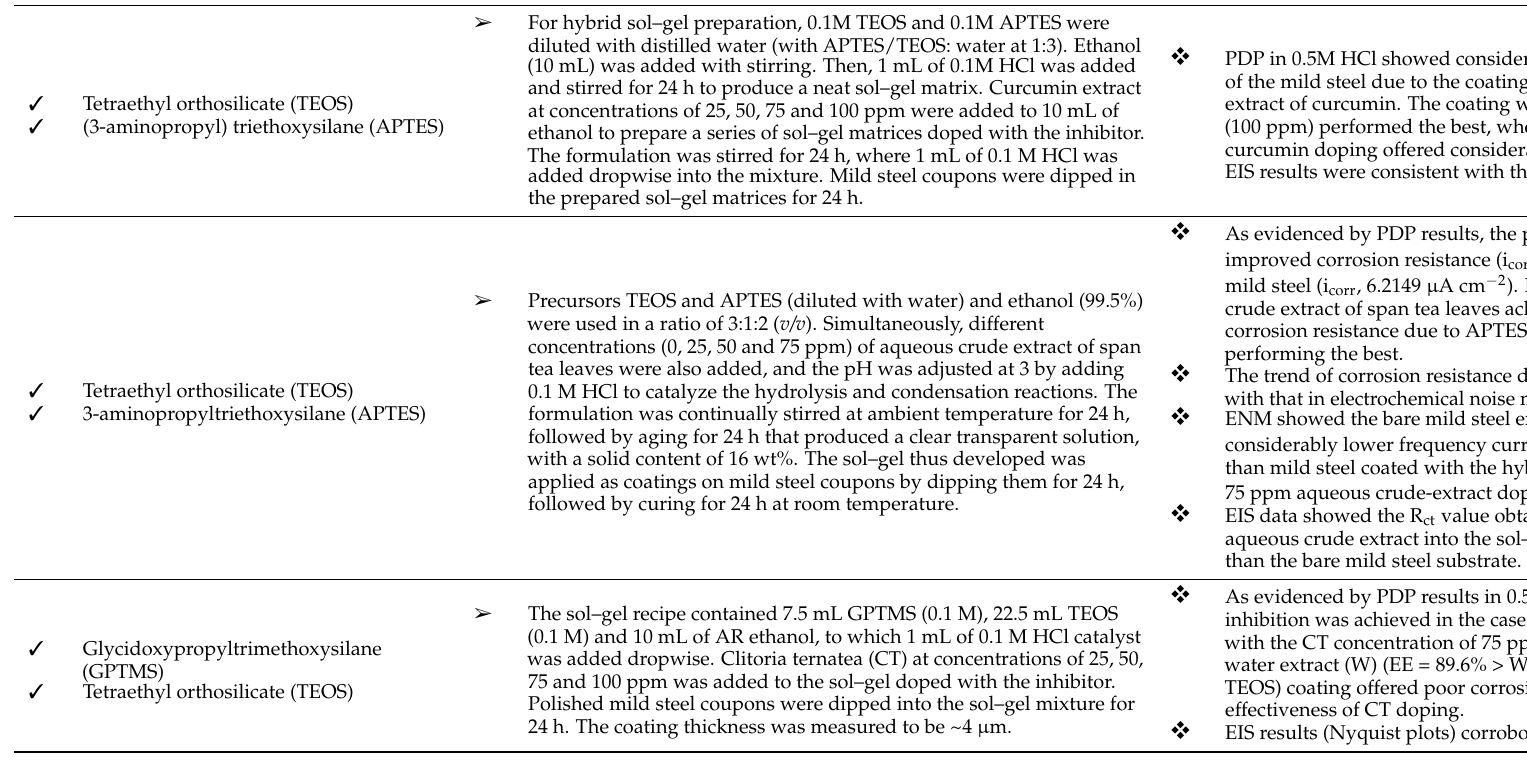
Table 1. Cont . Table 1. Different approaches for improving silane coatings and the main findings, as reported in the literature. Coating Preparation Main Findings Ref. Coating Preparation Main Findings Ref.